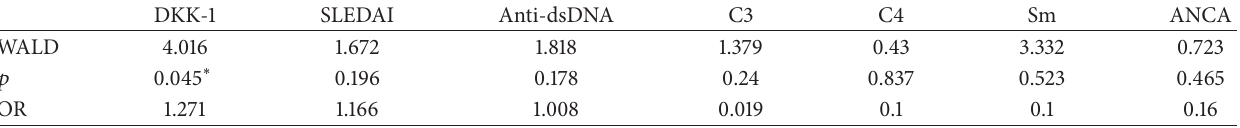
Table 5: Multiple-factor nonconditional logistic regression analysis of the impact of serological factors on LN-SLE.